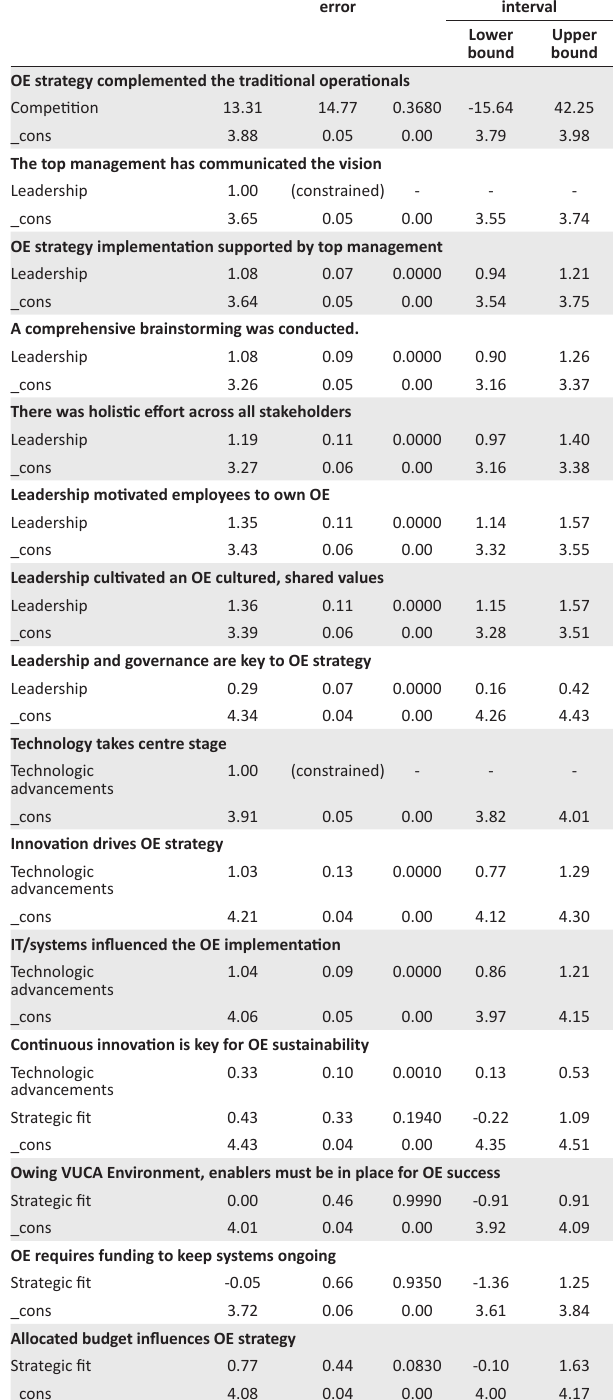
TABLE 3: The structural equation model. Measurement Coefficient Robust std.